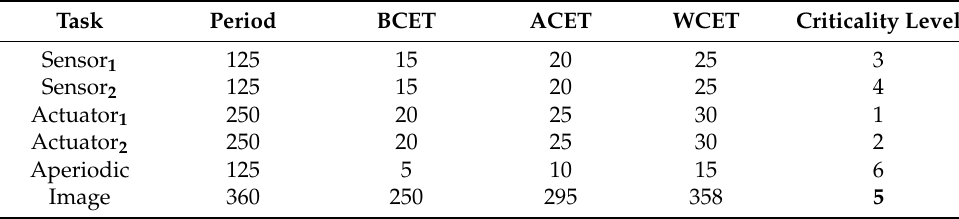
Table 2. Simulated task